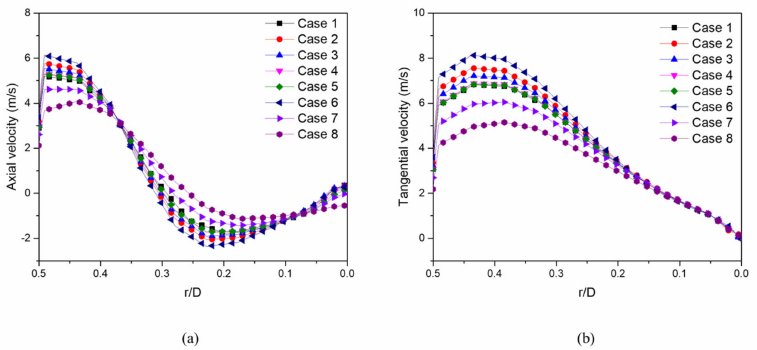
Figure 7. CFD (Computational fluid dynamics) results at 4D s downstream of the ISE: ( a ) axial water velocity, ( b ) tangential water velocity.